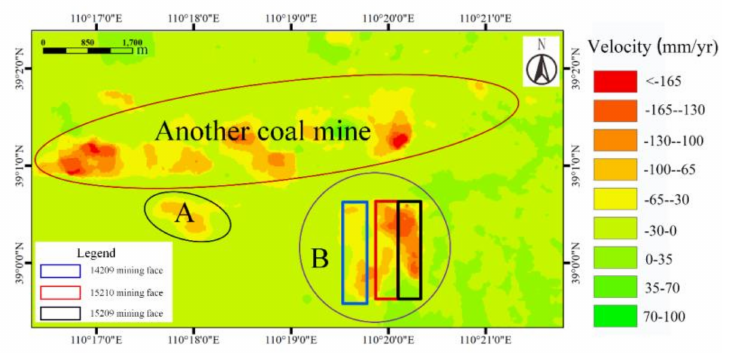
Figure 4. Subsidence rate diagram of the study area based on SBAS-InSAR technology (a negative value means a subsidence and a positive value means an uplift): (1) area A is a loose mound of the open-pit mining in another coal mine. (2) area B is the study